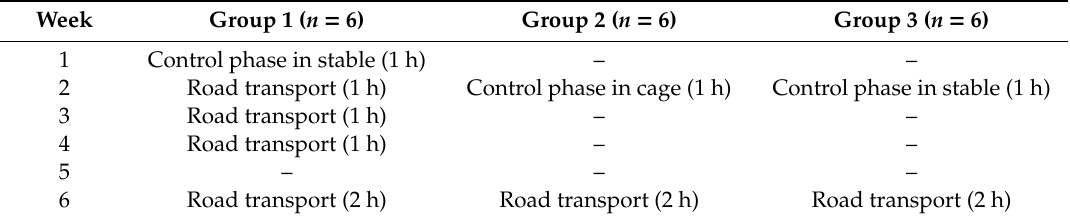
Table 2. Experimental groups and study